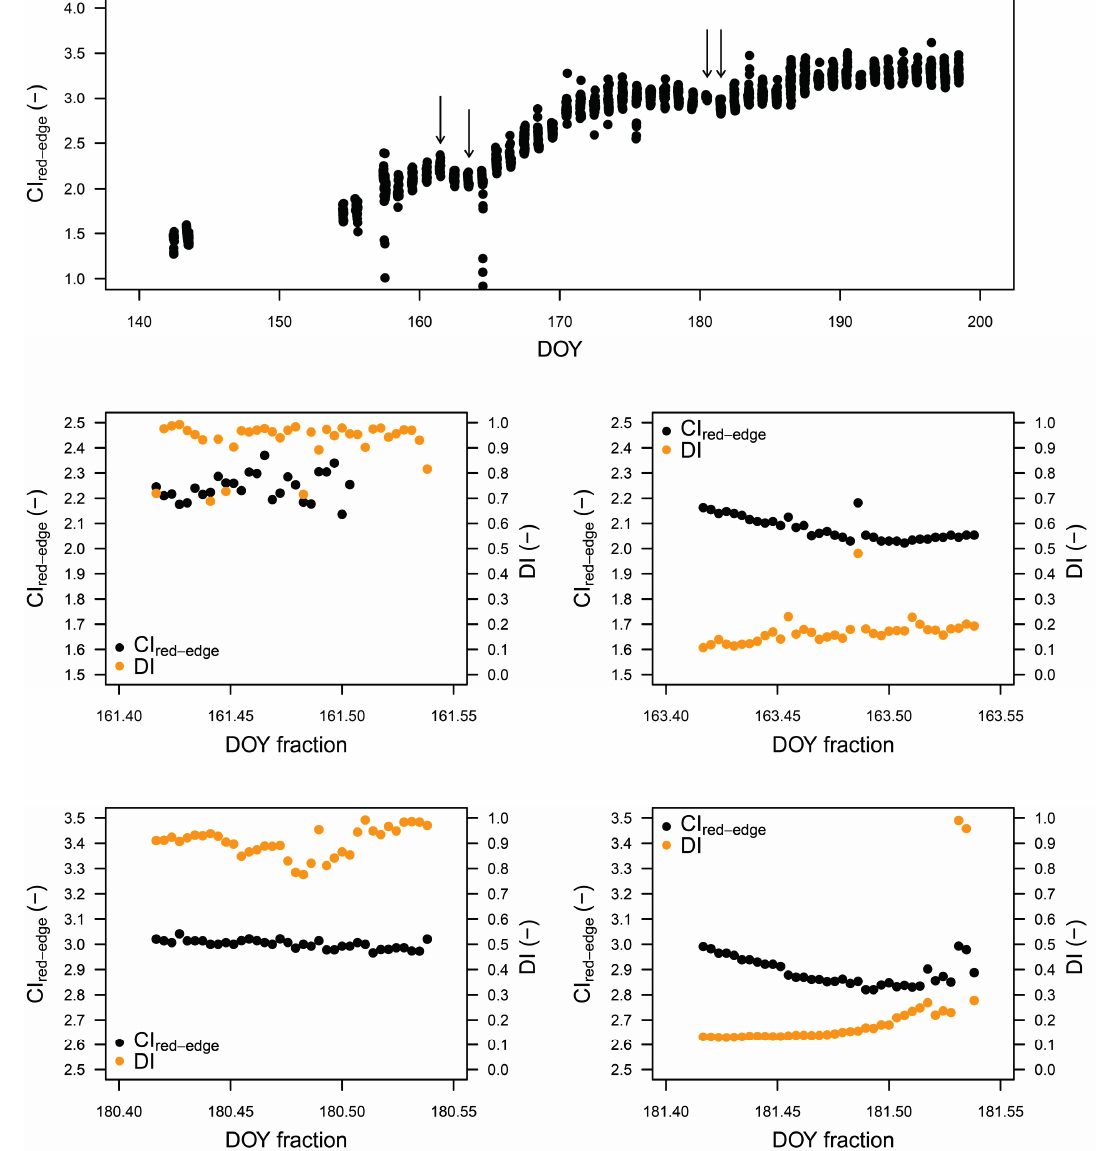
Figure 7. Example of Red Edge Chlorophyll Index (CI red-edge ) seasonal and diurnal time